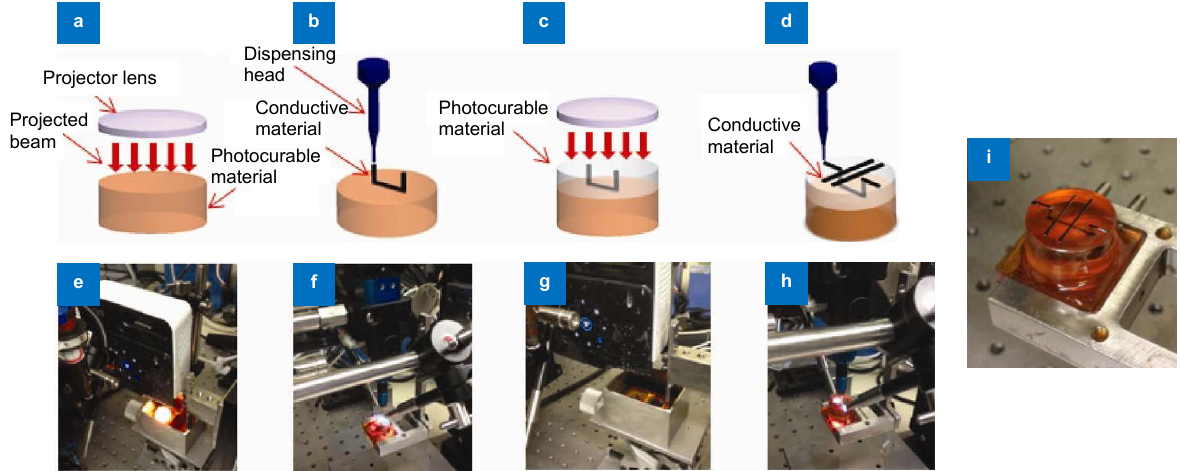
Fig. 7 | The hybrid 3D printing process and fabricated 3D structural electronics 10 . ( a ) Bottom insulating structure. ( b ) “U” shape wire. ( c ) Top insulating layer. ( d ) Wires on top surface. ( e ) P μ SL of the bottom insulating structure. ( f ) DWC of the “U” shape wire. ( g ) P μ SL of the top insulating structure. ( h ) DWC of wires on the top surface. ( i ) Fabricated 3D structural electronics with embedded